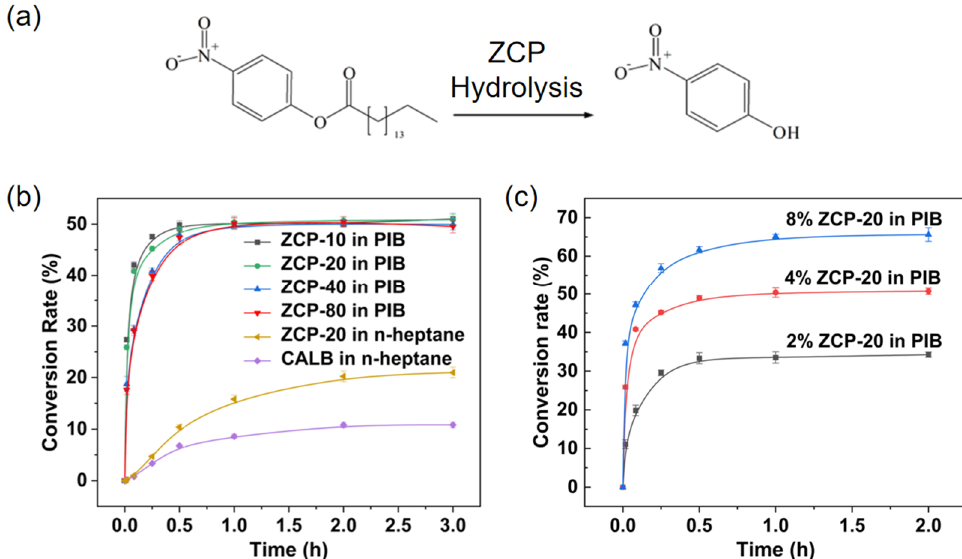
Figure 6. Interfacial biocatalytic performance for Pickering emulsion stabilized by ZCP. ( a ) The reaction of p -NPP hydrolysis to yield p -NP; ( b ) Time-dependent conversion of p -NPP catalyzed by different enzyme levels of ZCP in the PIB system and by CALB and ZCP-20 in the n-heptane system; ( c ) Time-dependent conversion of p -NPP catalyzed by different concentrations of ZCP-20 interfacial biocatalysts.